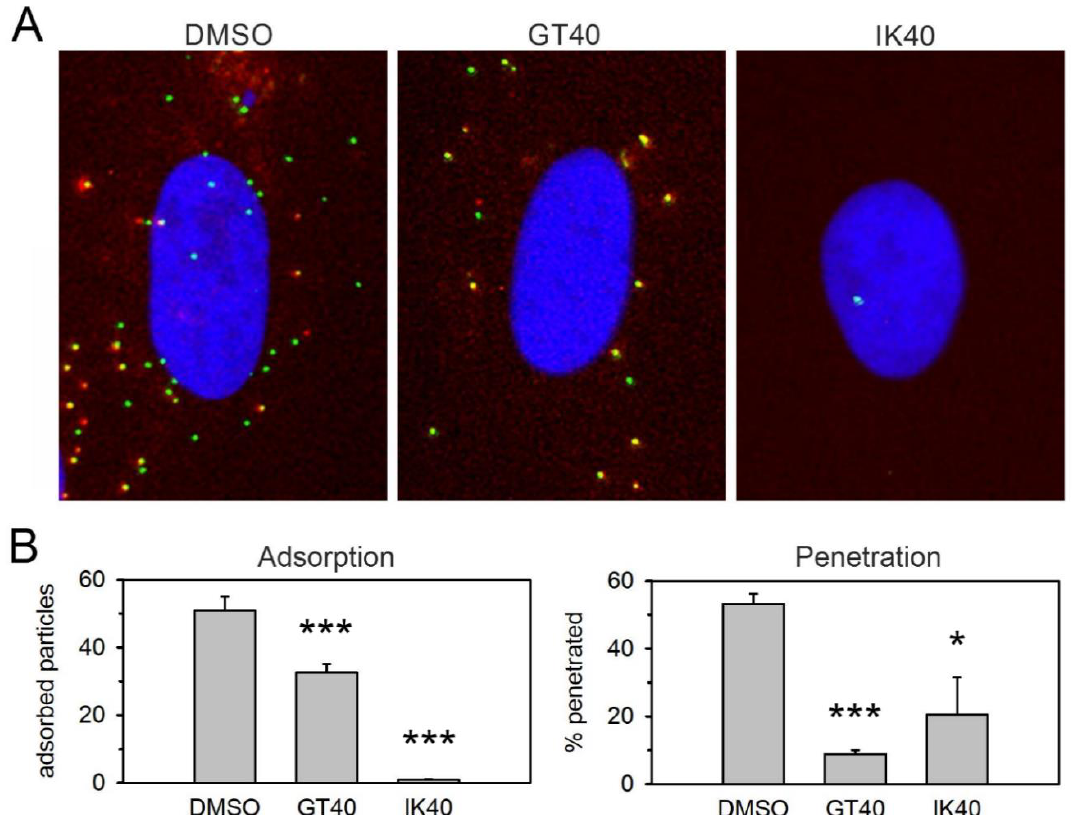
Figure 2. Effect of peptides on adsorption and penetration. A freshly produced virus preparation of TB40-BAC-KL7-SE- UL32EGFP-UL100mCherry was incubated with the respective peptide at a final concentration of 30 µmol/L or a DMSO control at 37 °C for 2 h. Fibroblasts (HFFs) were then infected with the virus–peptide mixture for 20 min at 37 °C, washed with medium, and fixed with paraformaldehyde after a total duration of 2 h. One representative of three experiments is shown. ( A ) Example images showing the effect of the respective peptide as compared to the DMSO control. Enveloped virus particles appear yellow by the superposition of red (envelope; pUL100-mCherry) and green (capsid; pUL32-EGFP) signal. Penetrated particles fluoresce exclusively in green due to loss of the envelope. ( B ) Particle signals from 20 cells were counted for each experimental condition. Adsorption: number of all pUL32-EGFP positive signals per cell. Penetration: percentage of particles per cell that show only green fluorescence without red fluorescence. Bars indicate mean values and error bars indicate the standard error of the mean. Asterisks indicate statistical significance of the differences (* = p < 0.05; *** = p < 0.001).